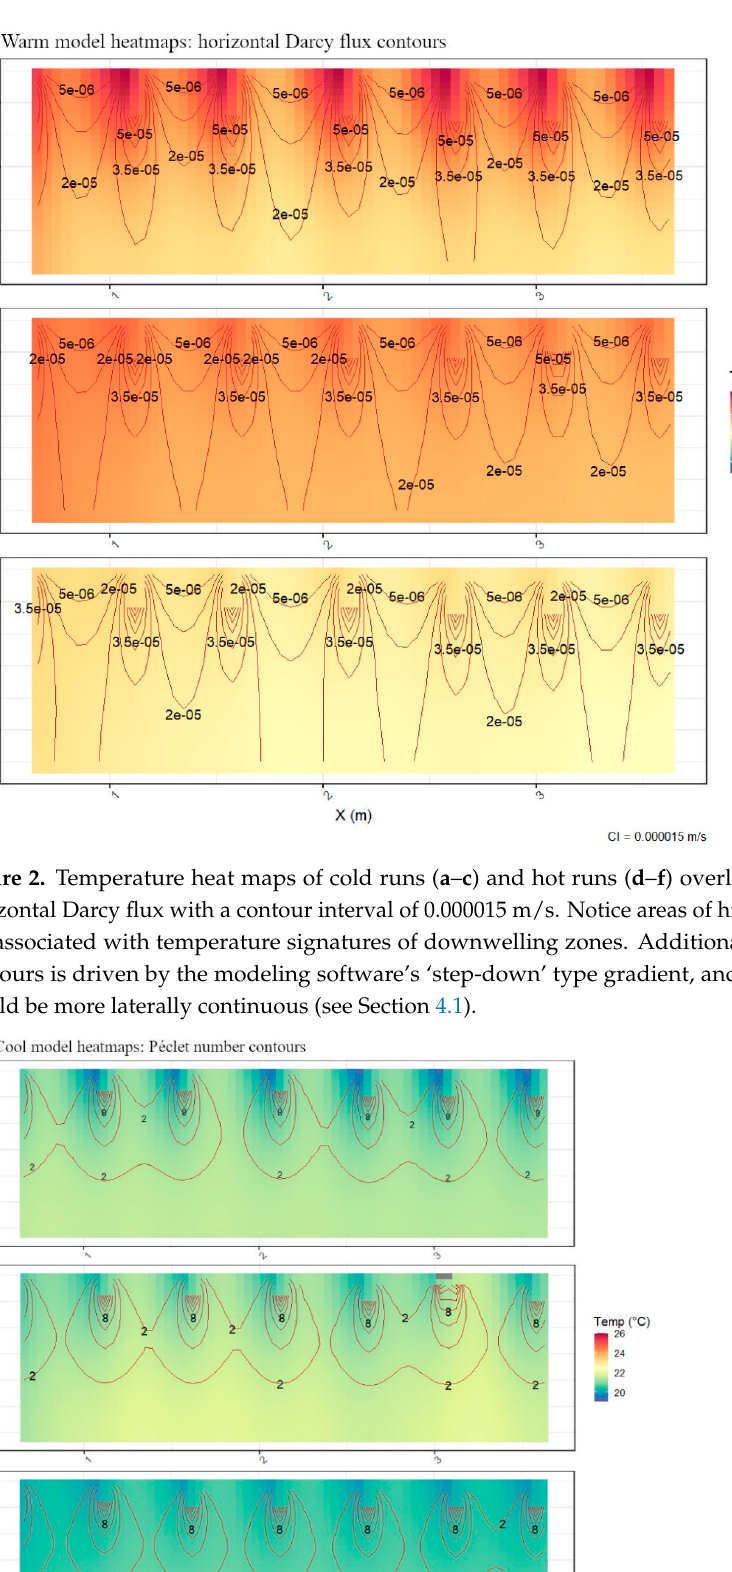
Figure 3. Temperature heat maps of cold runs ( a – c ) and hot runs ( d – f ) overlain with contours of Pe numbers with a contour interval of 2. Notice areas of highest Pe number are associated with